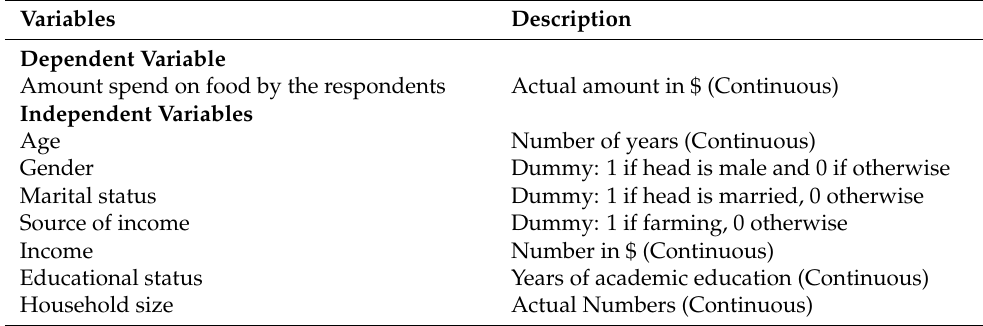
Table 2. Variable descriptions for factors affecting food expenditure